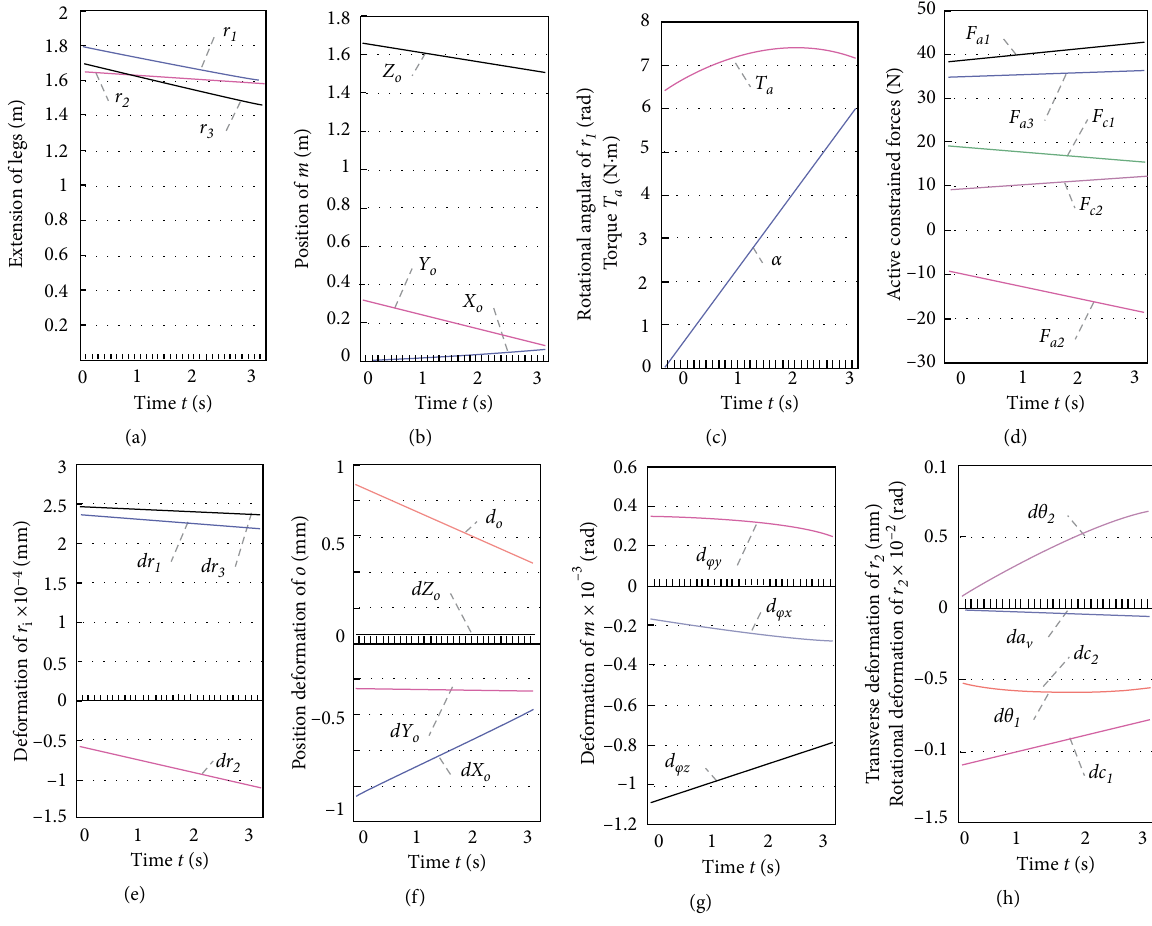
Figure 4: Theoretical solutions of elastic deformations of 2SPS + RRPR